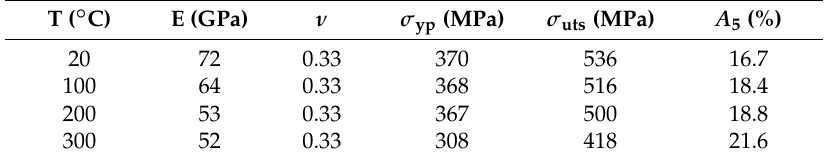
Table 1. Material parameters of the EN AW 2024 T3 alloy obtained for different temperature values [4].